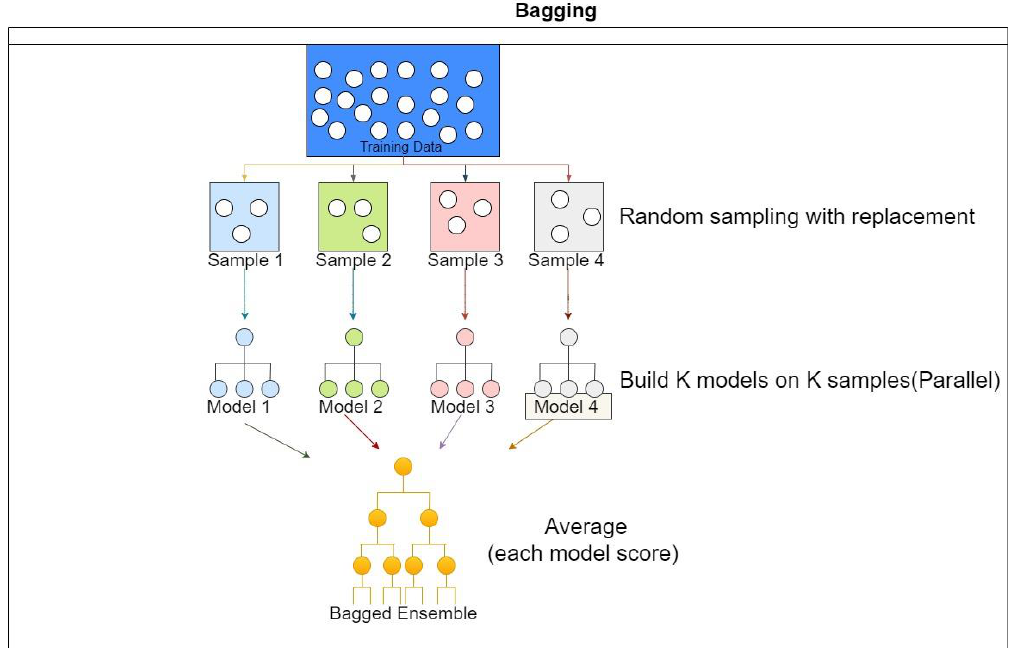
Figure 9. Ensemble classification scheme.